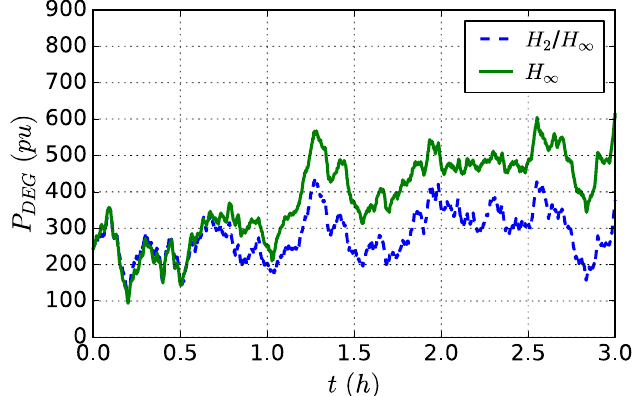
Figure 7. Power dynamics of FCs under mixed 𝐻 (cid:2870) /𝐻 (cid:2998) control and 𝐻 (cid:2998) control schemes.